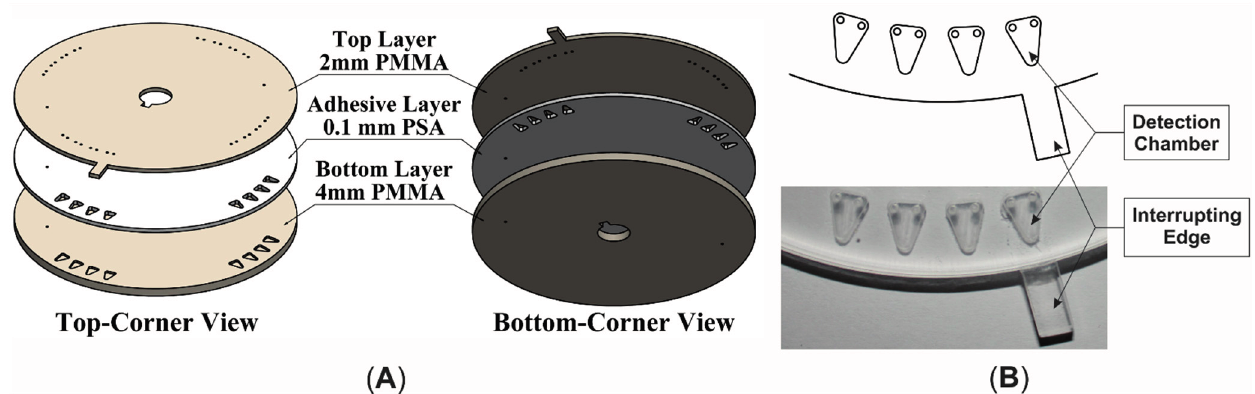
Figure 1. Microfluidic CD ( A ) 3D expanded view; ( B ) Top view of the featuring section.